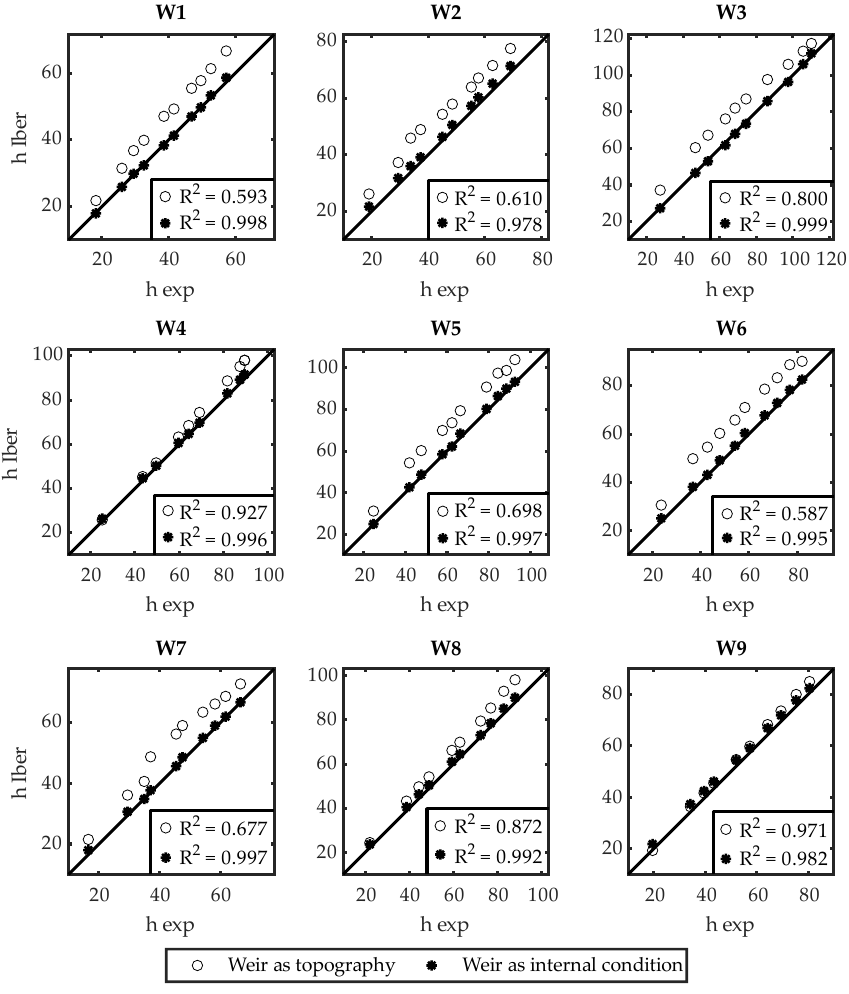
Figure 9. Comparison of the numerical and experimental water depth. Water depth refers to the value above the weir crest level and was measured at the control point (CP). Units in mm.